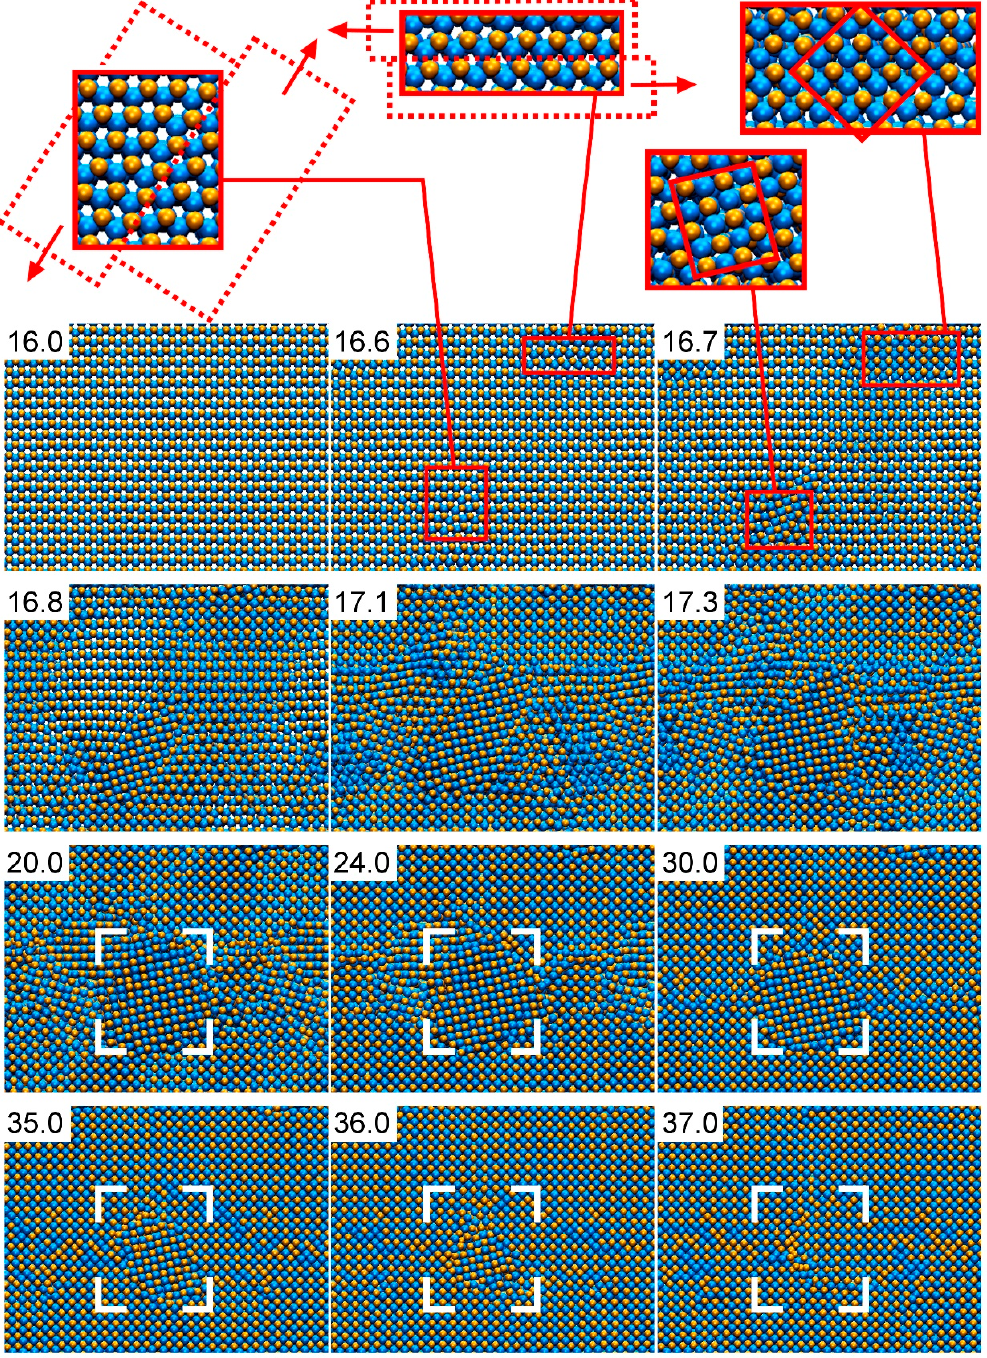
Figure 10. CMD simulation snapshots of the B4- to B1-AlN phase transformation induced by pressure. B4-AlN is seen from the [0001] direction. See text for details and explanation of the features observed in the figure.